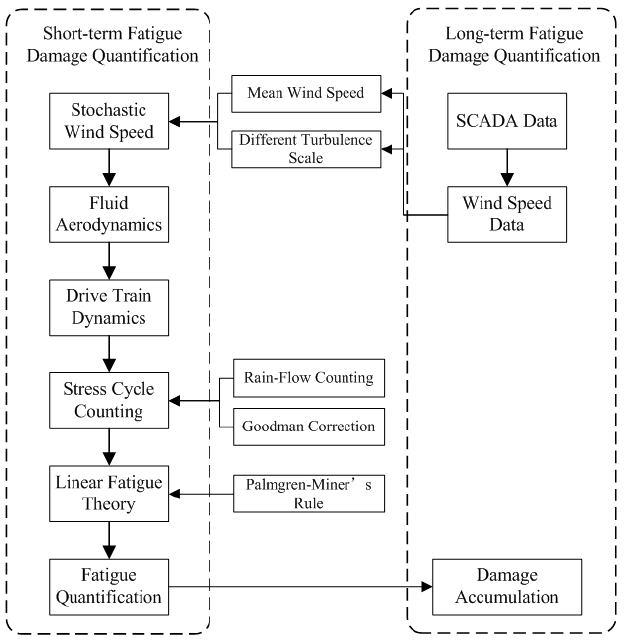
Figure 1. Flowchart of using supervisory control and data acquisition (SCADA) data to quantify gearbox gear fatigue damage.